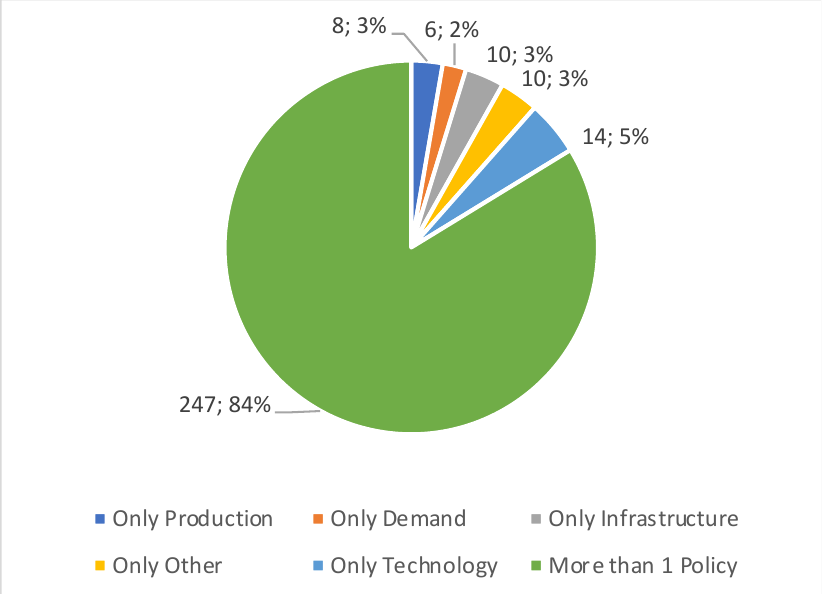
Figure 6. Studies focusing on a single policy type. Source: Autho rs’ own elaboration .